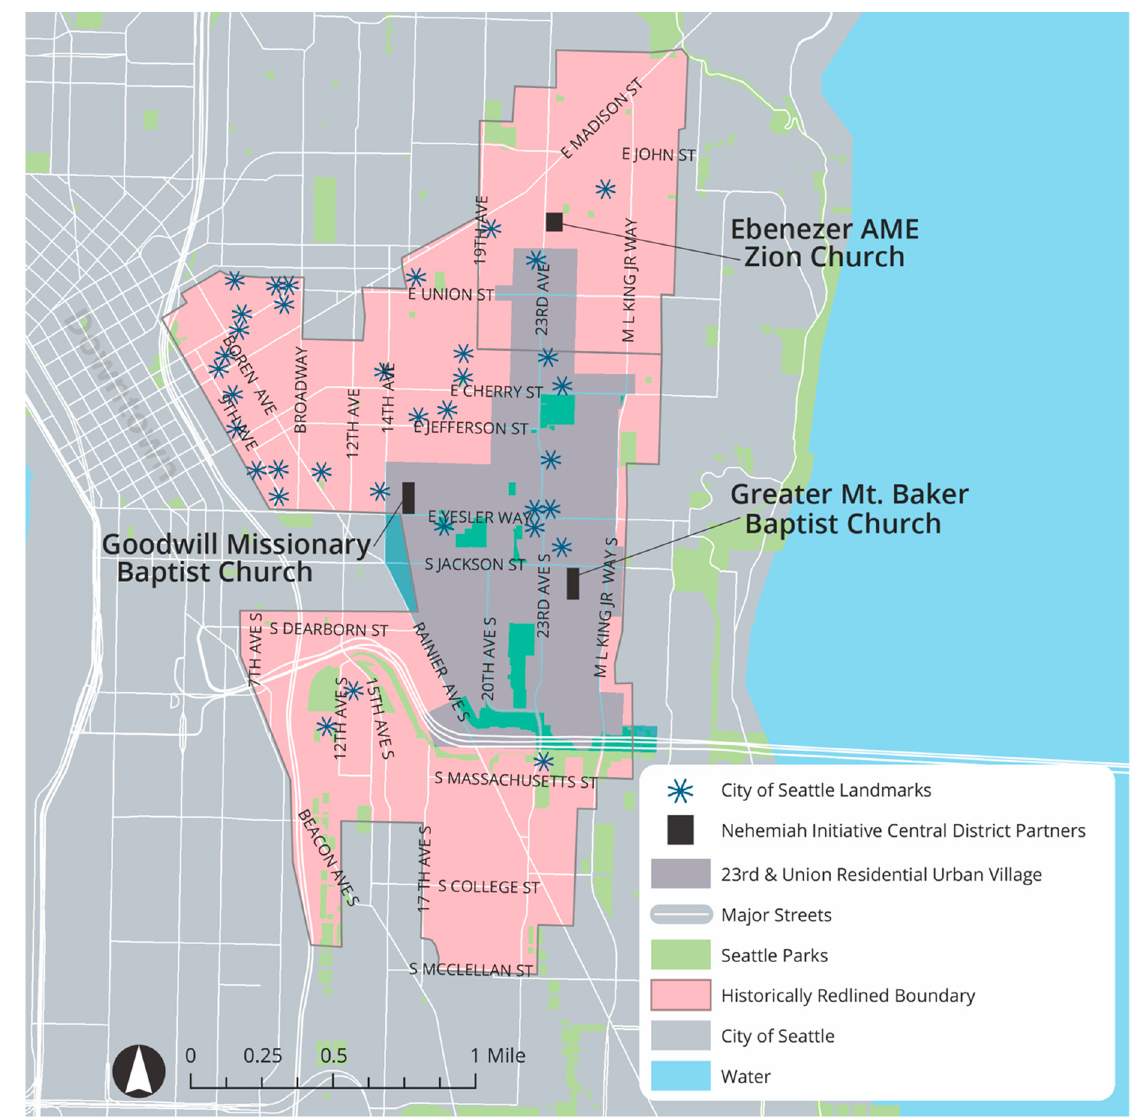
Figure 6. McKinley Futures Nehemiah Studio sites. Source: Mt. Baker Team (Building Beloved Community, p. 18).